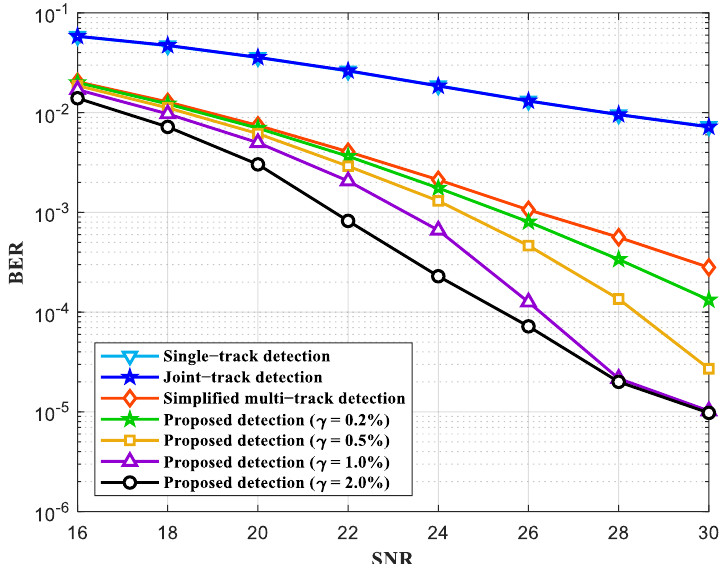
Figure 5. BER performances for the various detection schemes with 10% TMR when an areal density is 3.5 Tb/in 2 .